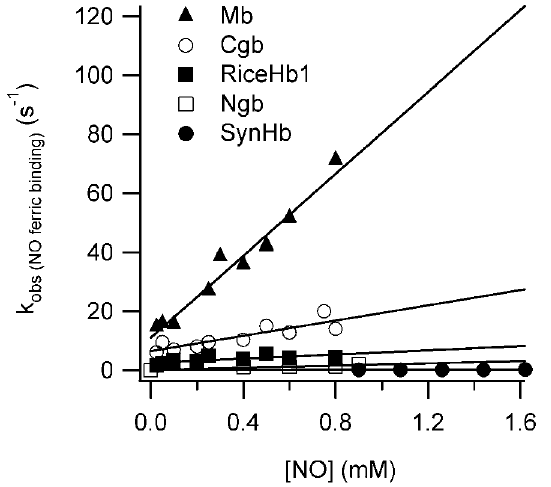
Figure 3. NO binding to ferric Mb and hxHbs. Plots of k obs versus [NO] for Mb and each hxHb. Time courses giving rise to these values were measured at different [NO] ranging from 50 to 1700 m M (after mixing) and were fitted to a single exponential to extract the observed rate constants (k obs ). A linear fit of these data provides the observed ferric NO binding association rate constant (k obs, NO(Fe3 + ) ).